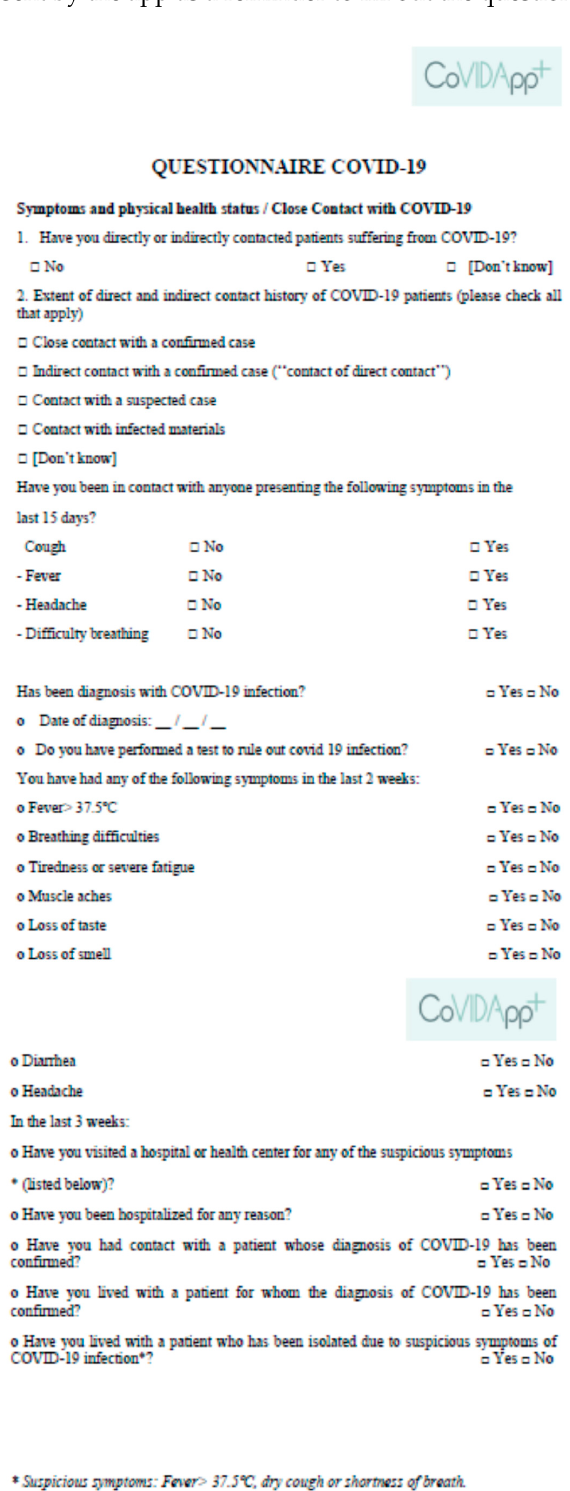
Figure 1. Questionnaire filled out daily by the workers to report symptoms or close contact with COVID-19.